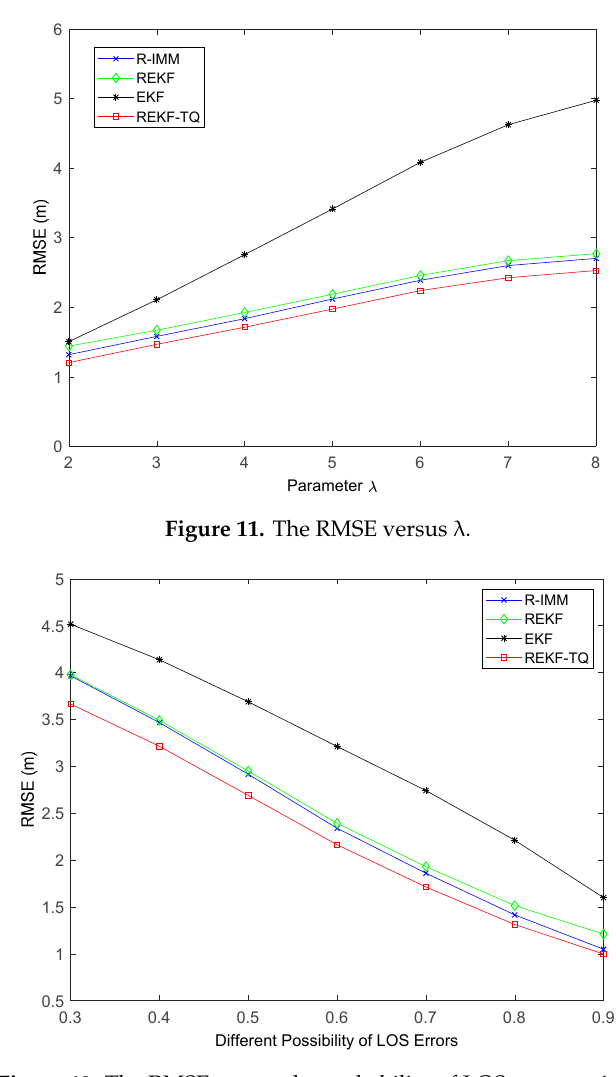
Figure 12. The RMSE versus the probability of LOS propagation.